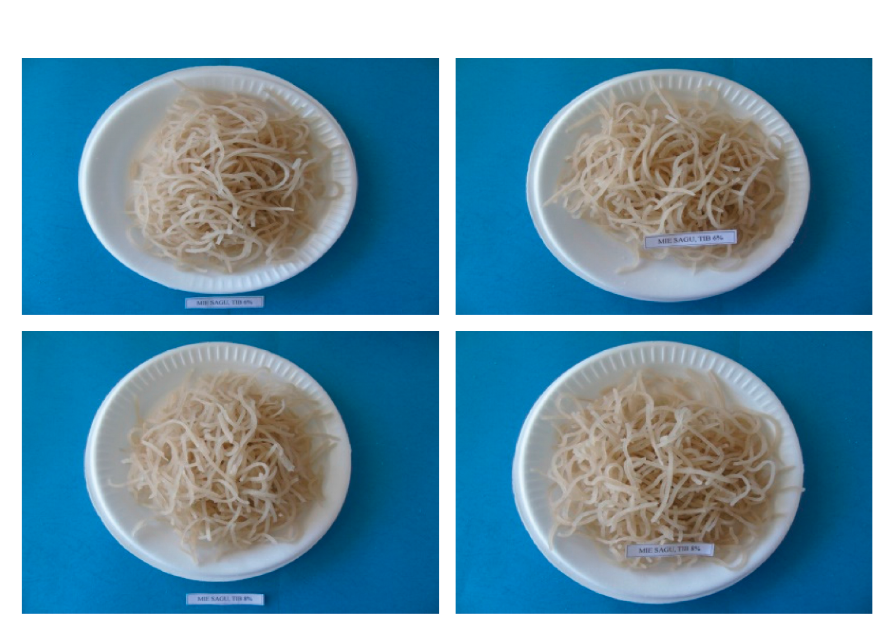
o , M 1 , M 2 , and M 3